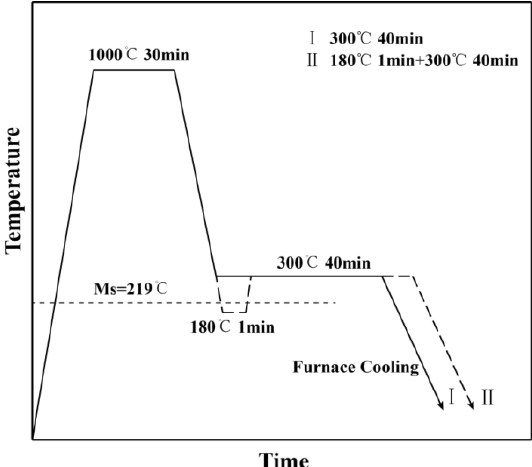
Figure 1. Schematic illustration of heat treatments: (I) quenching followed by isothermal bainite transformation (QBT), (II) direct isothermal bainite transformation (DIT).